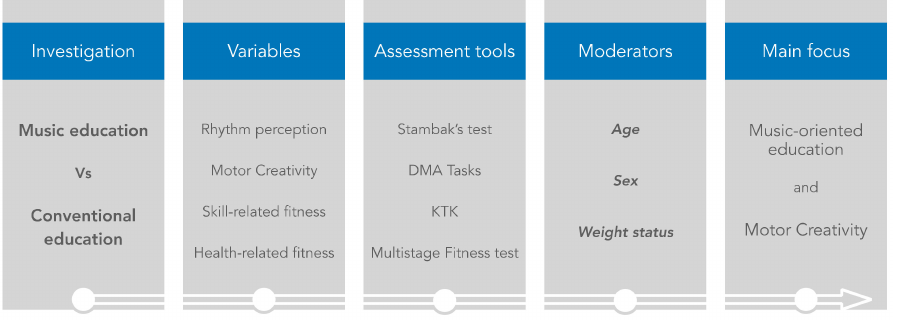
Figure 1. Schematic representation of the experimental concept. (DMA) Divergent Movement Ability. (KFK) Körperkoordinationstest für